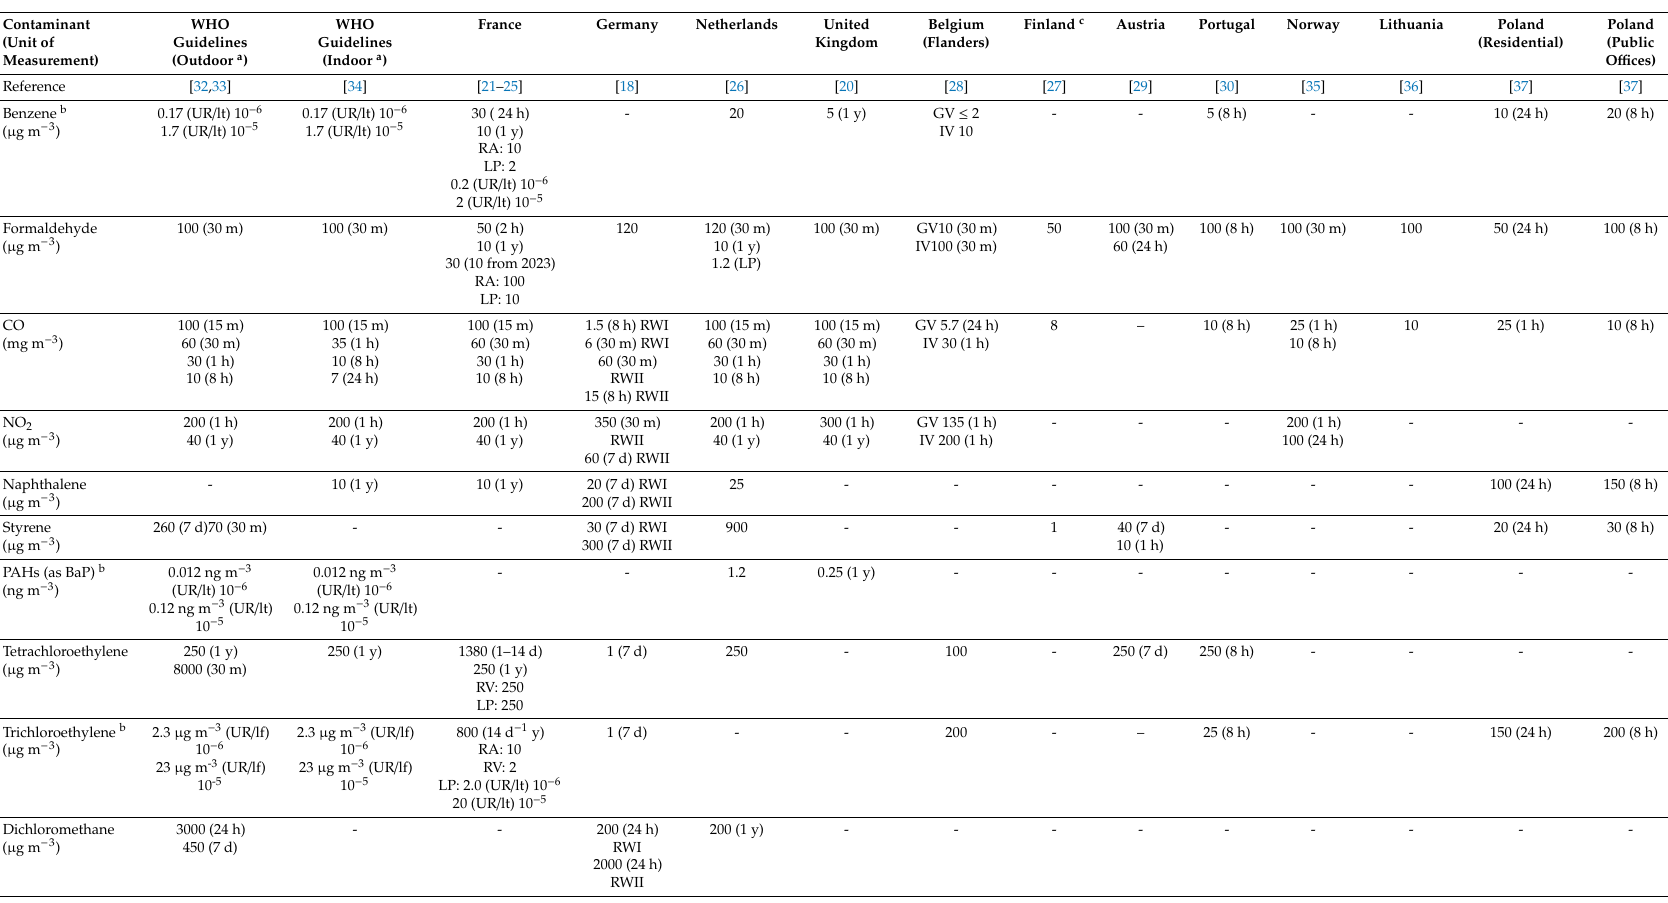
Table 2. Indoor air contaminants: reference values used in some European countries, guide values, and unitary risk of the World Health Organization (WHO). Contaminant (Unitof